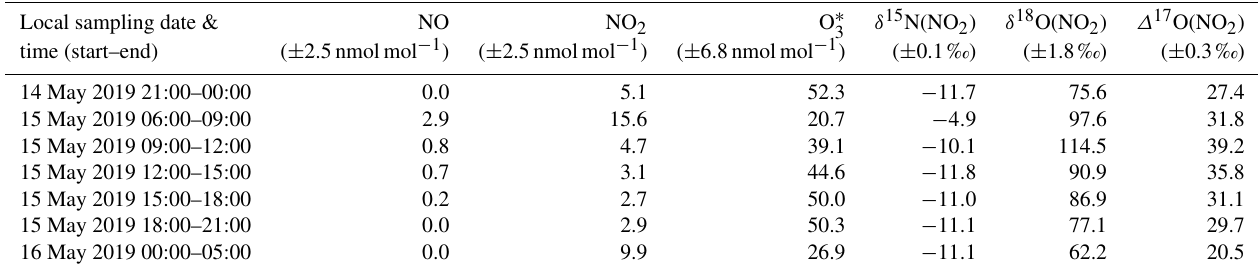
Figure 2. Temporal evolution of (a) NO (open circles) and NO 2 (closed circles) at the sampling site (the envelops represent ± 1 σ variations over 1h) and of (b) O 3 (closed circles) and O x ( = O 3 + NO 2 ; open circles) at the air quality station during the sampling period. Markers represent for (a) the hourly mean derived from 1min measurements and for (b) the hourly mean provided by the air quality monitoring station. Global solar radiation flux is represented by dashed lines (measured at 200m from the sampling site by the IGE weather station with a Skye SP1110 pyranometer). Table 1. Summary table of sampling periods (dates, local times), NO, NO 2 , and O 3 mean mixing ratios over the collection periods, as well as calibrated NO 2 isotopic measurements of δ 15 N, δ 18 O, and ∆ 17 O. All the sampling periods lasted 3h except the last one that lasted 5h. Averaged measurement uncertainties are provided just below the species